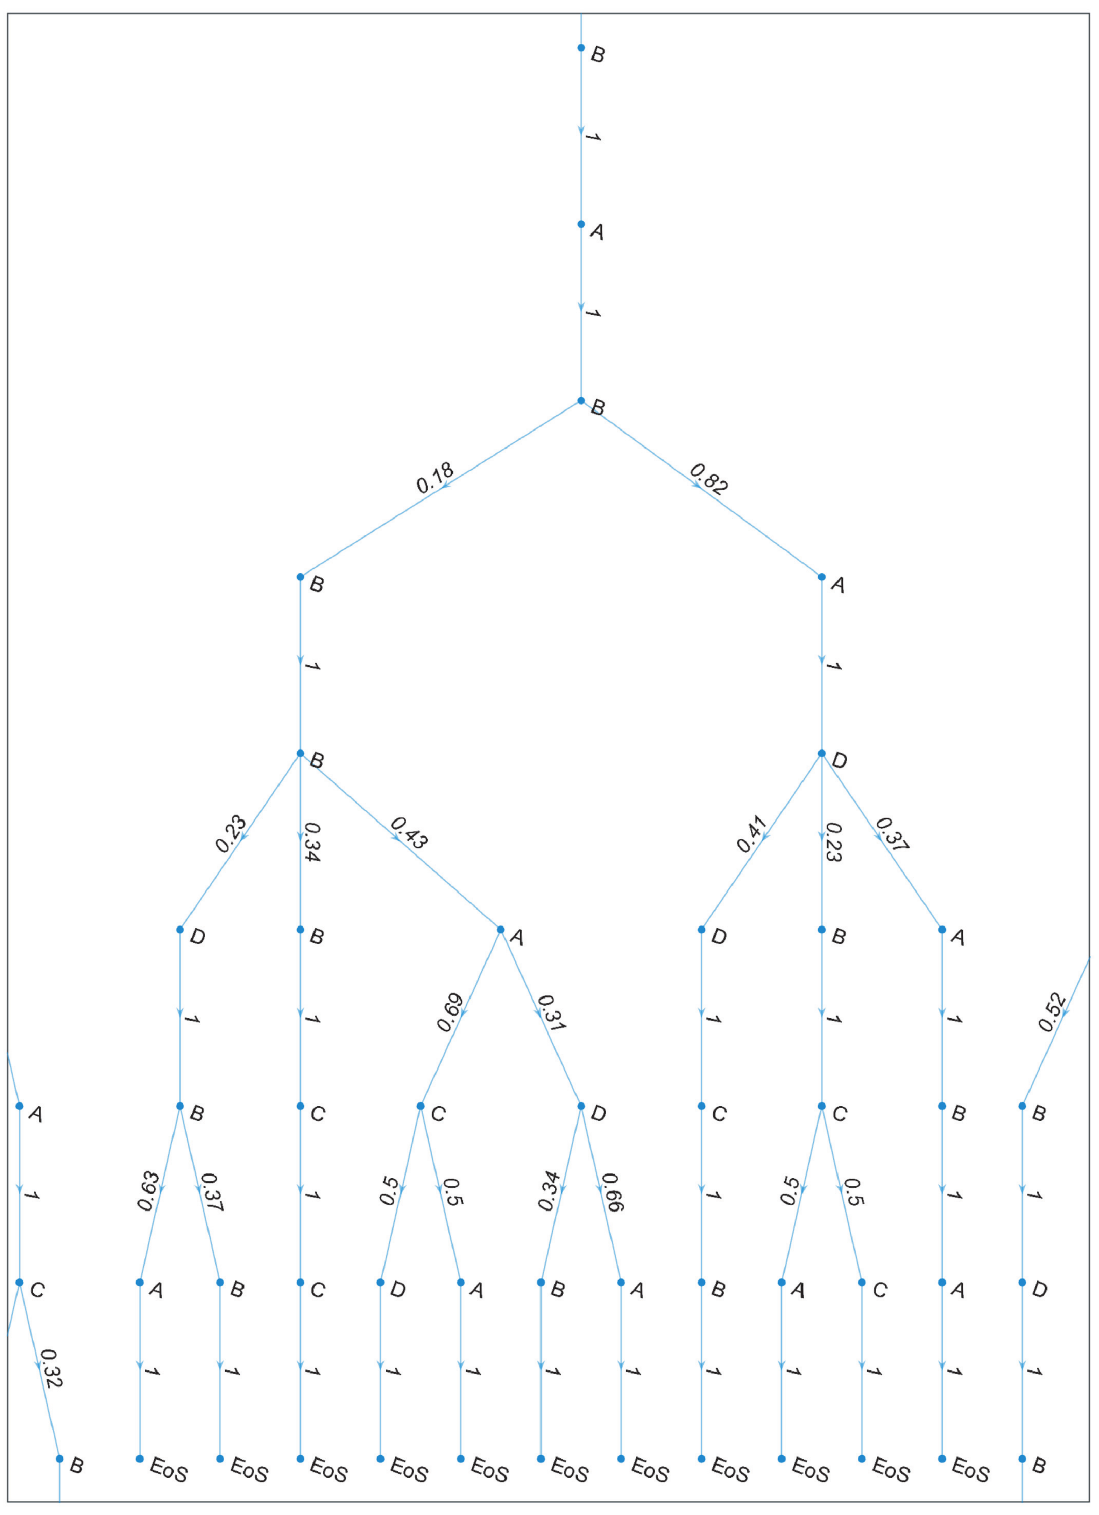
Figure 11: The state transition probabilities of the full tree-based system, assuming [B] event